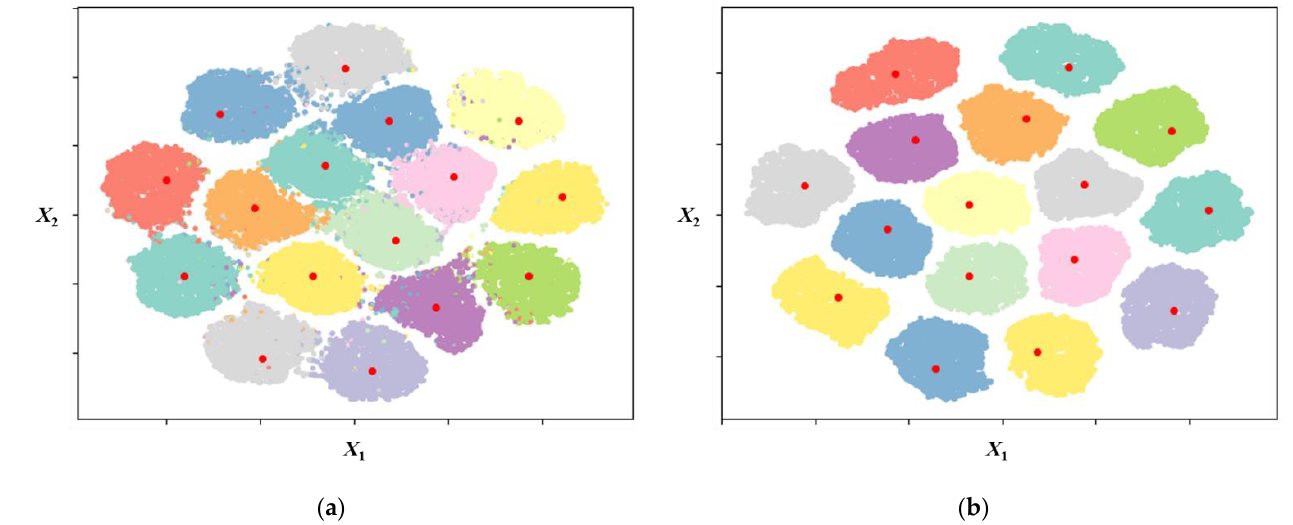
Figure 5. Scatter plot of the received sequences and centroids: ( a ) SNR = 6 dB; ( b ) SNR = 14 dB. Table 3. Centroids of K-means decoder according to hard and soft decision at SNR = 14